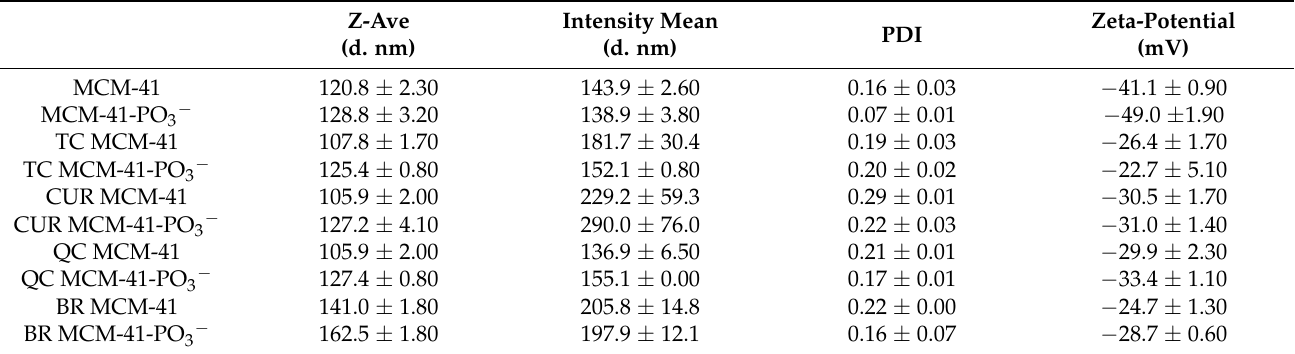
Table 1. Hydrodynamic (Z-Ave) and intensity mean diameters, polydispersity index (PDI), and Zeta-potential measurements for SrtAI-loaded and non-loaded MCM-41 and MCM-41-PO 3 − MSNs.